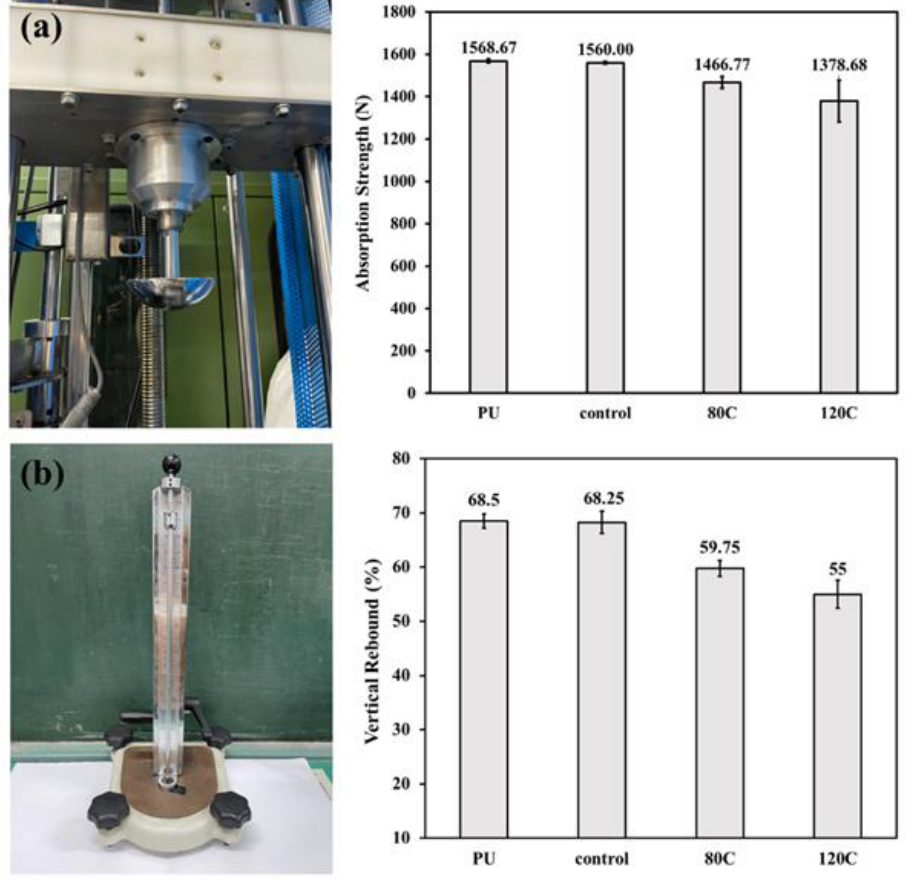
Figure 3. ( a ) Buffer absorption and ( b ) vertical rebound rate of PU foam composites.